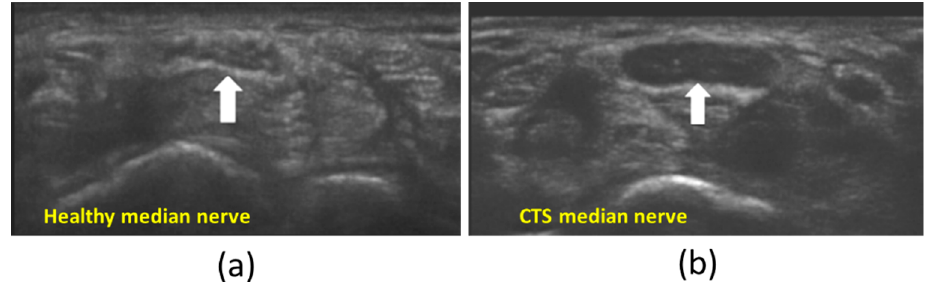
Figure 2. US B-mode images in the transverse plane (short axis plane) of the median nerve (white arrow) in ( a ) a healthy participant and ( b ) a patient with carpal tunnel syndrome (CTS). The fascicles detected in the healthy median nerve cannot be seen in the CTS patient. This figure was previously presented by Vlassakov and Sala-Blanch [5]. Reprinting permission is granted through Rightslink system. Minor modifications were performed for presentation purposes.